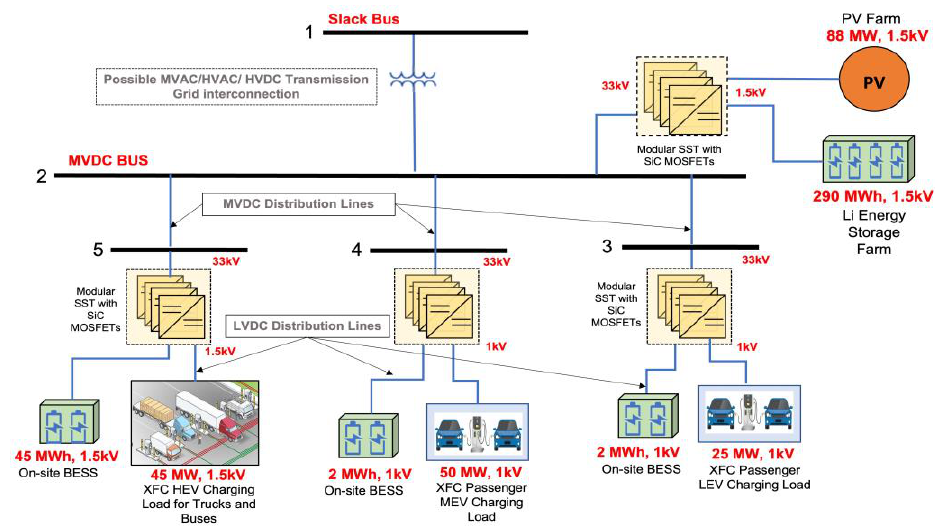
Figure 10. Modified 5-bus radial MVDC distribution system.